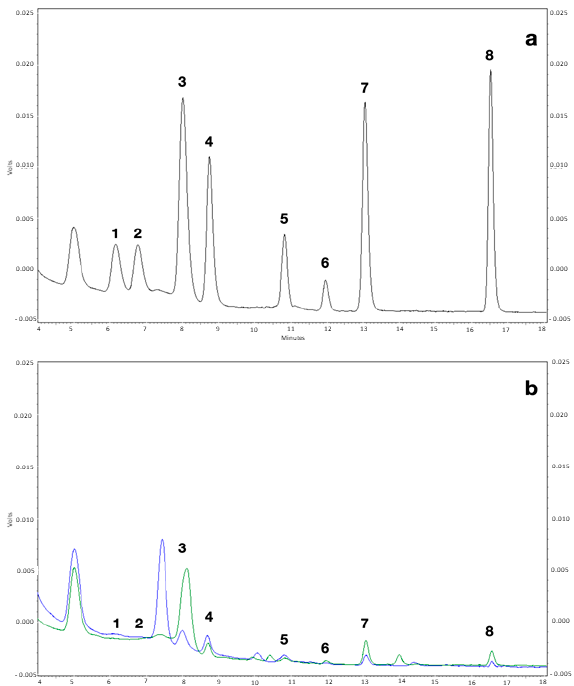
Figure 2. HPLC-FD chromatograms. ( a ) Standard solution. ( b ) Green trace: Barley milk sample, Blue trace: Rice milk sample. 1 β -PEA 2 PUT, 3 CAD, 4 HIS, 5 SER, 6 TYR, 7 SPD, 8 SPM.